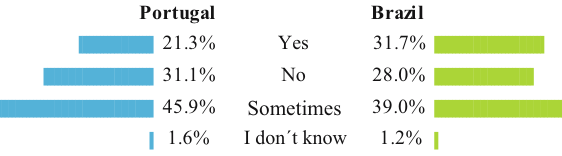
Figure 4: Answers to the question “ If you do not take breakfast, do you feel any di ff erence? ”